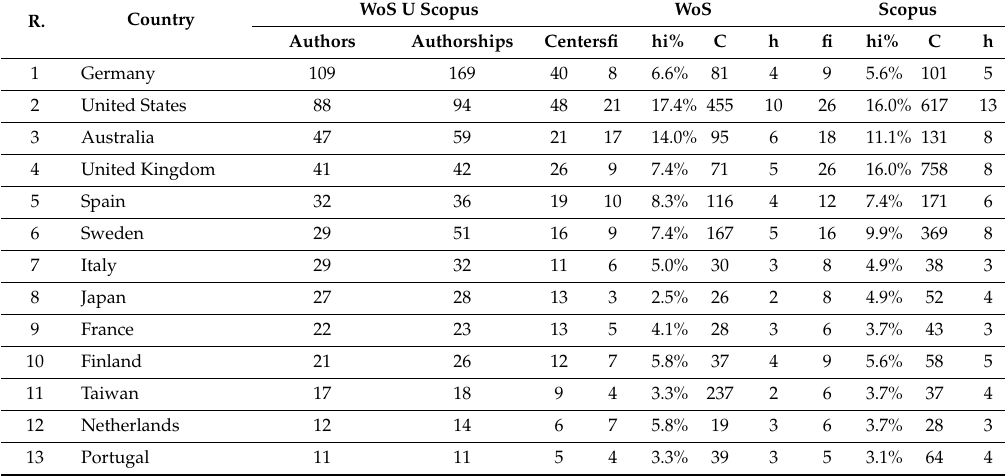
Table 4. Main countries according to the a ffi liation of the authors.